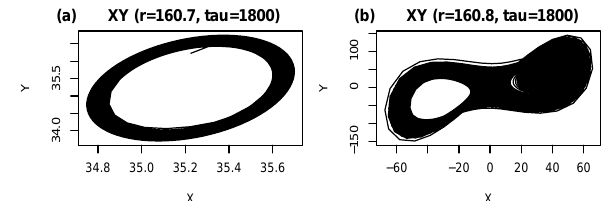
Figure 7. A transition from a stable solution with r = 160.7 to a chaotic solution with r = 160.8 in the 7DLM. The initial conditions are given near the critical point in Eq. (36b) (i.e., ( X , Y , Z , Y 1 , Z 1 , Y 2 , Z 2 ) = ( X c , Y c + 1, Z c − 1, Y 1c , Z 1c , Y 2c , Z 2c )). Note that a much larger integration time is used in the simulations.